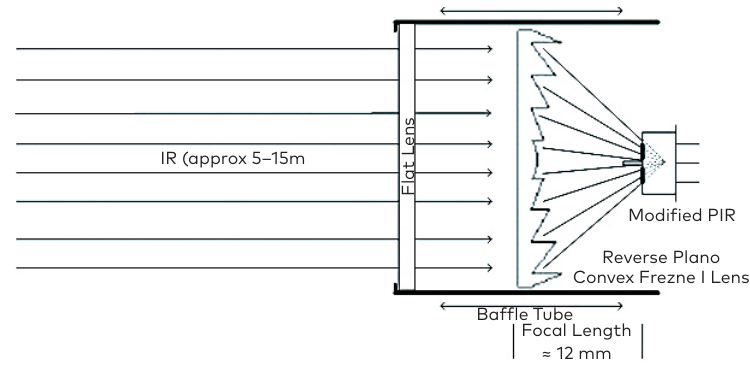
Figure 9. Long-range FoV lens schema